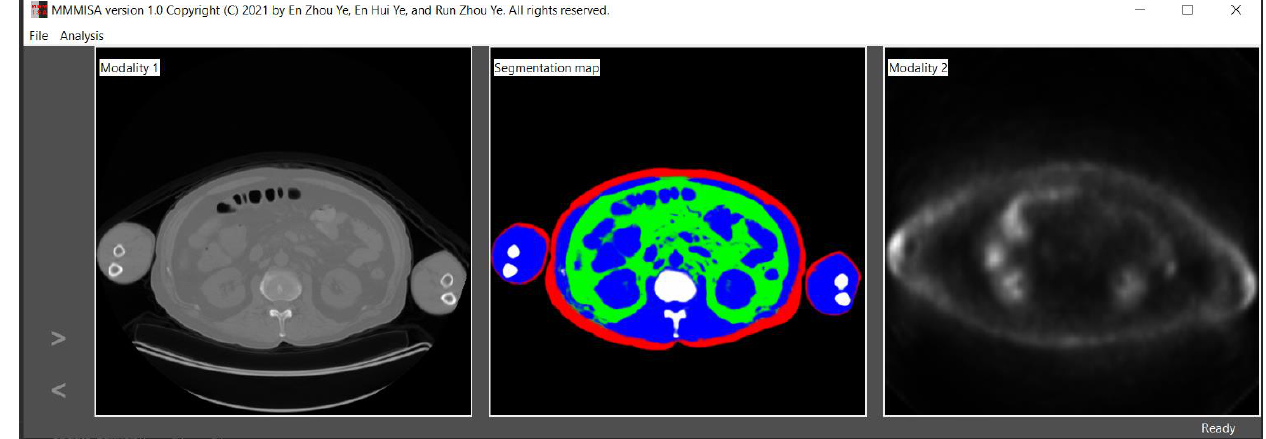
Figure 1. Main window of MMMISA, showing (from left to right), modality 1 (CT) images, segmentation maps generated with convolutional neural network, and modality 2 (PET) images